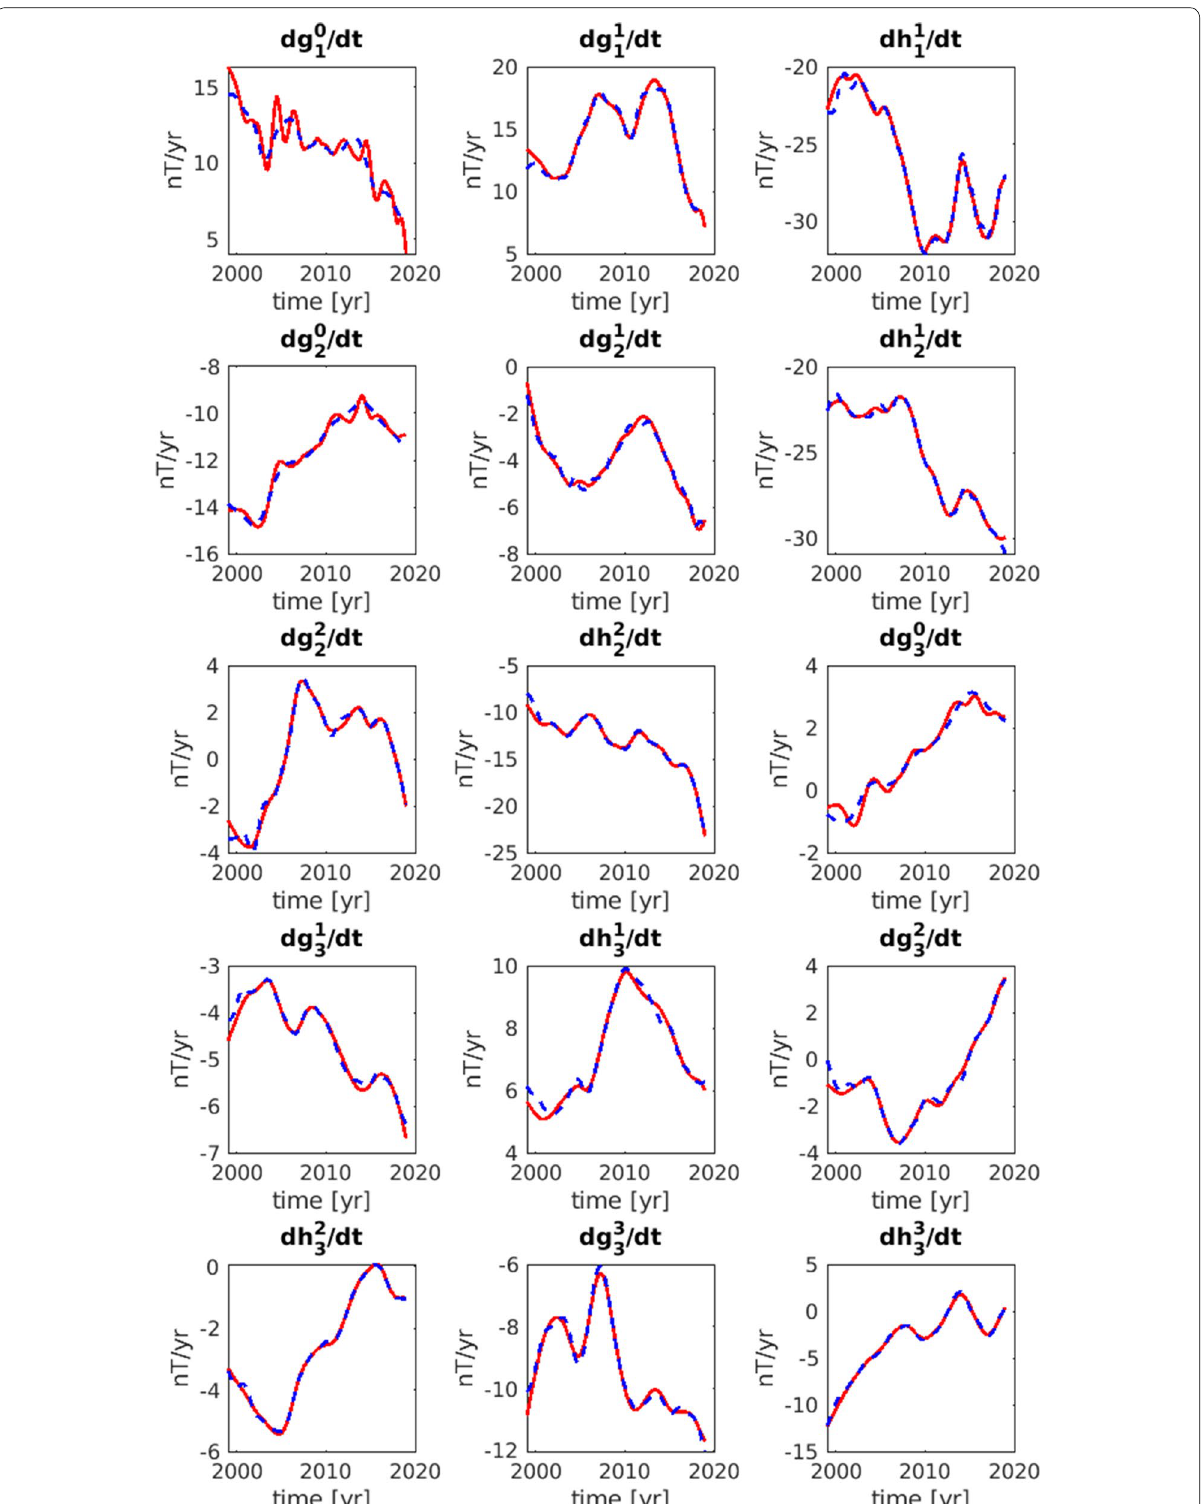
1 3 at radius a 6,371.2 km from CM6 (solid red) and CHAOS (dashed blue) from = − =